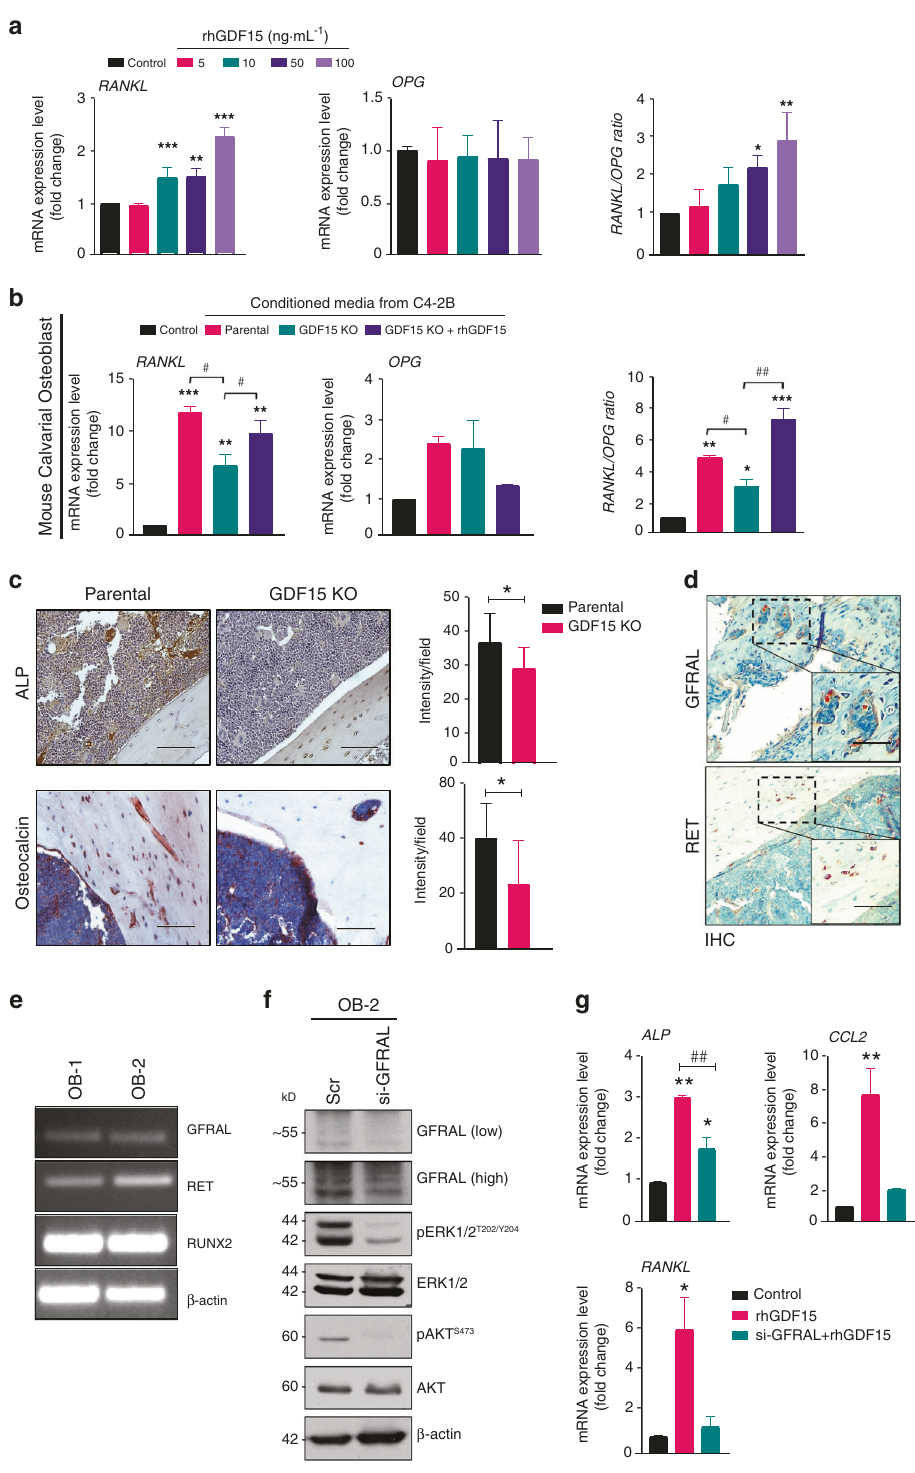
Fig. 6 GDF15 increases the osteoclastogenic potential of osteoblastic cells via an increased RANKL signal. a MCOs were treated with rhGDF15 for 48 h, and the mRNA expression levels of RANKL and OPG and the ratio of RANKL/OPG expression, representing the degree of osteoclastogenesis, were assessed. b RT – qPCR analyses showing the mRNA expression and ratio of RANKL and OPG in MCOs after treatment with CM from C4-2B cell lines (parental and GDF15 KO). c Immunohistochemistry of ALP and osteocalcin in bone sections obtained from C4- 2B- and C4-2B (GDF15 KO)-injected tibiae; (right panel) quanti fi cation ( n = 3 mice/group). Scale bar = 200 µm. d Immunohistochemistry of GFRAL and RET on the decalci fi ed tibiae of PC3-injected mice. Scale bar = 200 µm. e RNA expression of GFRAL, RET, and Runx2 in MCOs cultured in normal (OB-1) and osteoblast differentiation medium (OB-2) using β -actin as a control. f MCOs were transfected with siRNA targeting GFRAL and control siRNA; after 48 h of transfection, the cell lysates were analyzed for GFRAL, pERK, pAKT, and the respective total forms. β -Actin was used as a loading control. g mRNA expression analyses of ALP, CCL2, and RANKL in MCOs after 48 h of GFRAL siRNA transfection. The data represent the mean ± SEM. P ≤ 0.05 was considered to indicate statistical signi fi